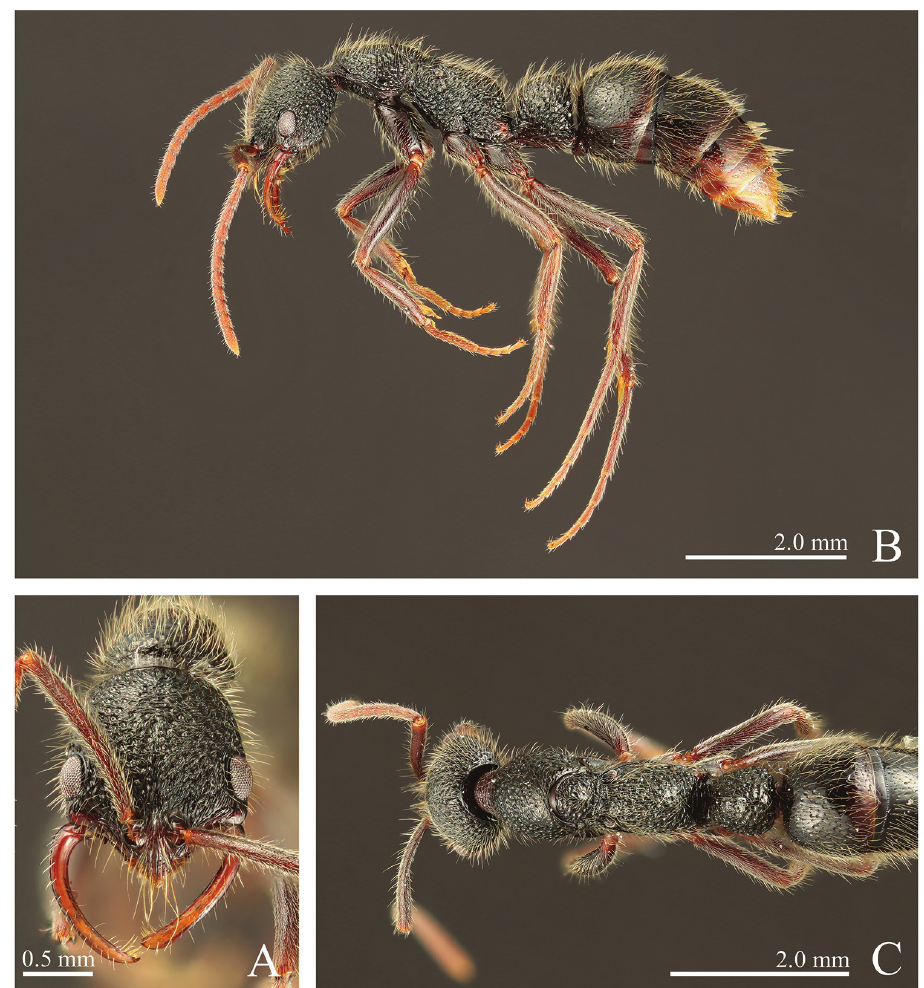
Figure 12. Leptogenys kanaoi sp. n., paratype, queen. A head, full-face view B lateral view C dorsal view.